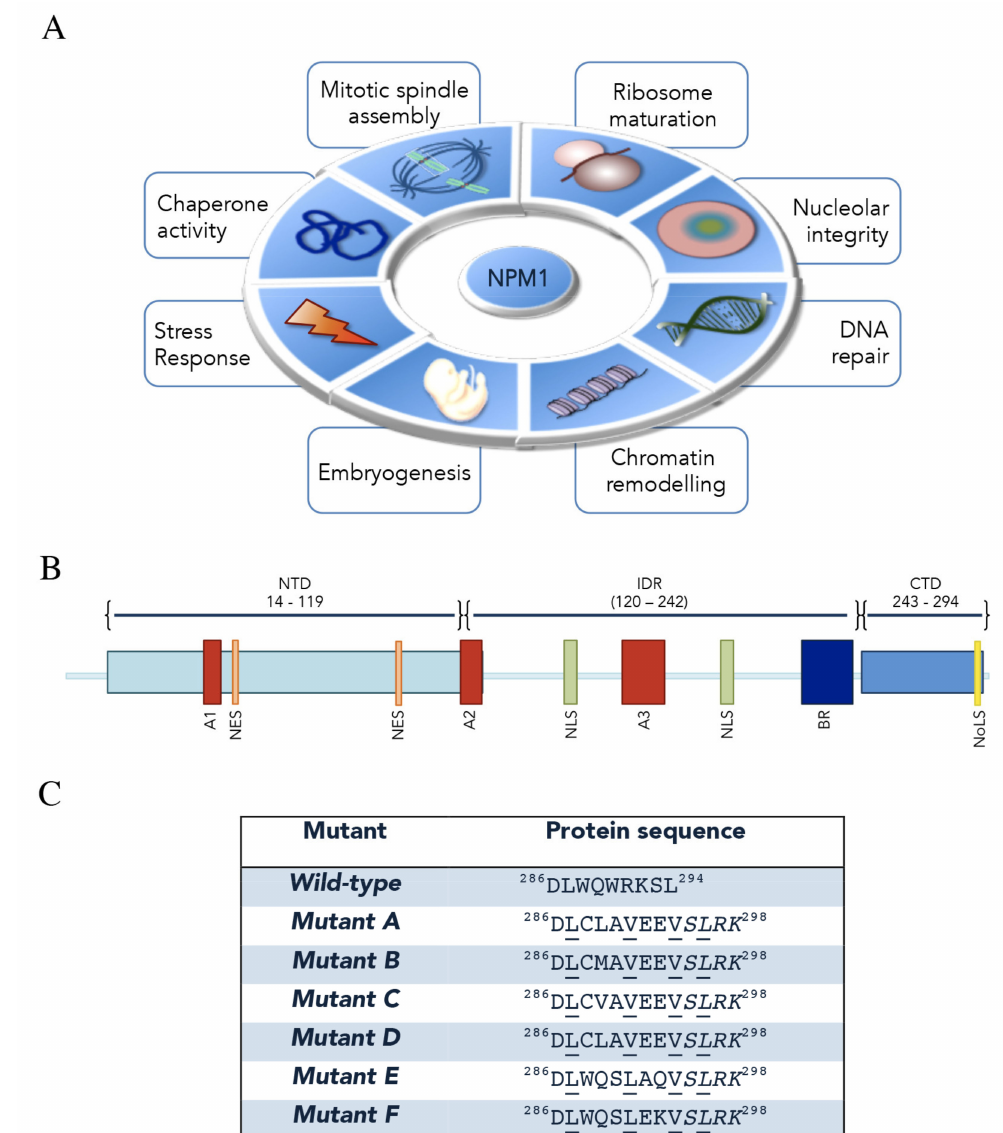
Figure 1. Nucleophosmin (NPM1) functions, structural organization and acute myeloid leukemia (AML) mutations. ( A ) The main functions played by NPM1 through its interactions with proteins and nucleic acids are represented. ( B ) NPM1 is composed of a N-terminal domain (NTD) preceded by a methionine-rich short sequence. NTD contains two nuclear export signals (NES) and a short acidic tract (A1). NTD is followed by an intrinsically disordered region (IDR) which contains two acidic tracts (A2 and A3), a bipartite nuclear localization signal (NLS) and a basic region (BR). Finally, a positively charged C-terminal domain (CTD), which contains the nucleolar localization signal (NoLS), is present. ( C ) Heterozygous AML-associated mutations cause the expression of a protein that is longer by four residues and has a di ff erent sequence in the last seven. A novel NES appears in all mutants (underlined residues). Here, the C-terminal sequences of wild-type and the most common mutants are